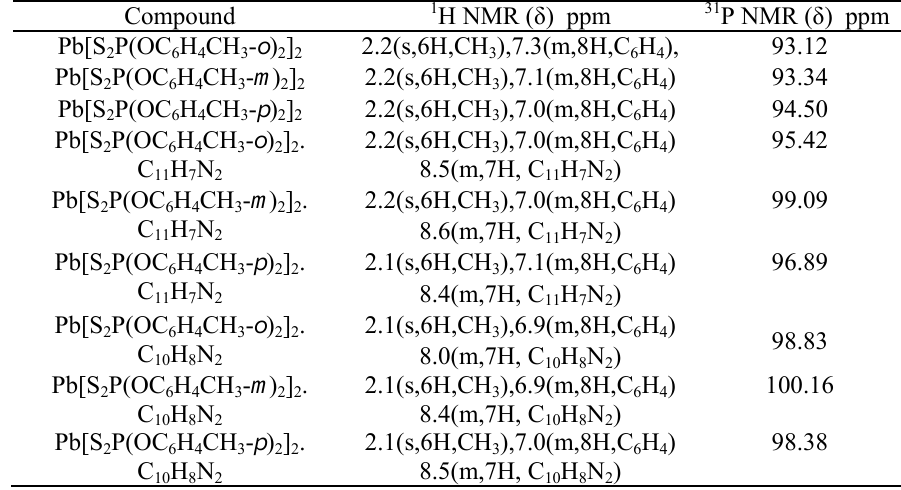
Table 2 . 1 H NMR and 31 P NMR spectral data of lead(II)bis{ O,O’ -ditolyldithiophosphates} complexes